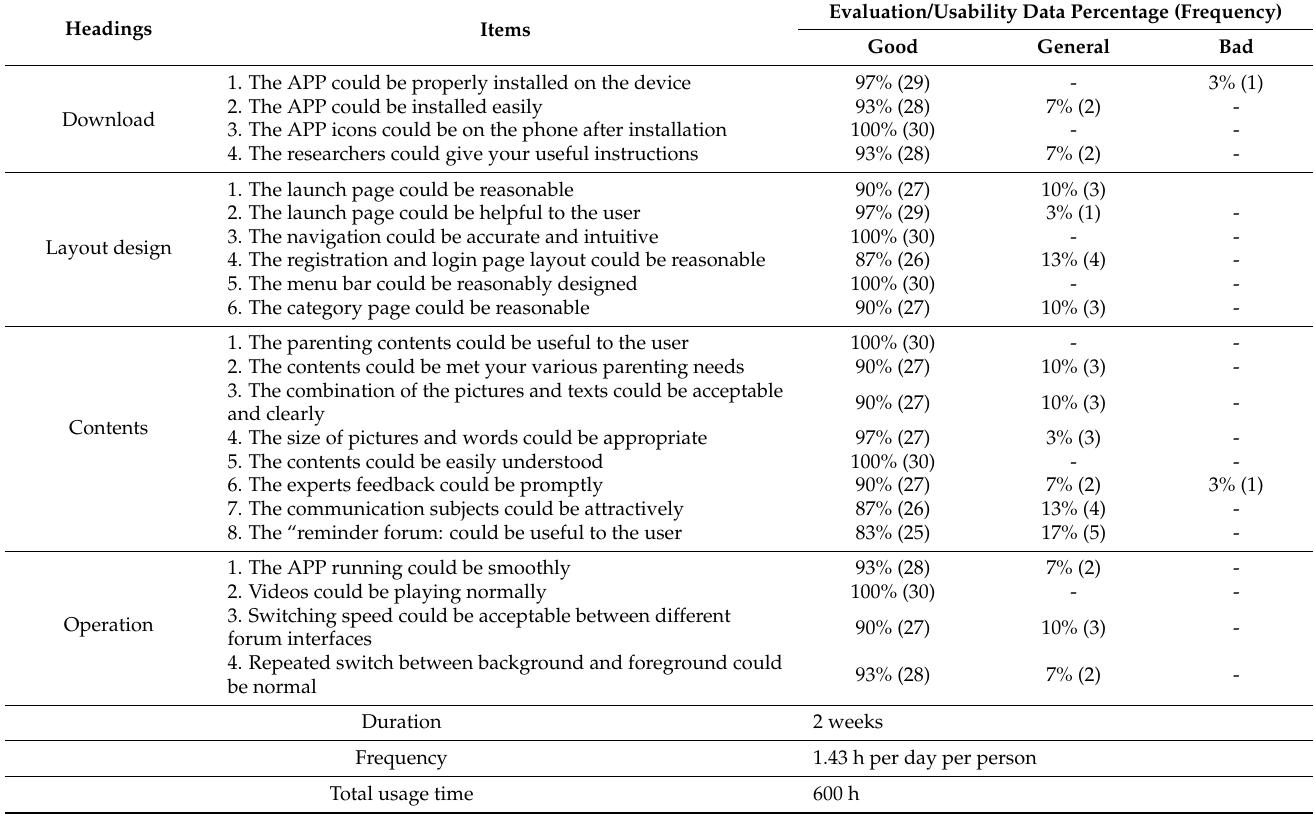
Table 2. The APP evaluation data of perceived ease of use and usefulness of participants ( n =